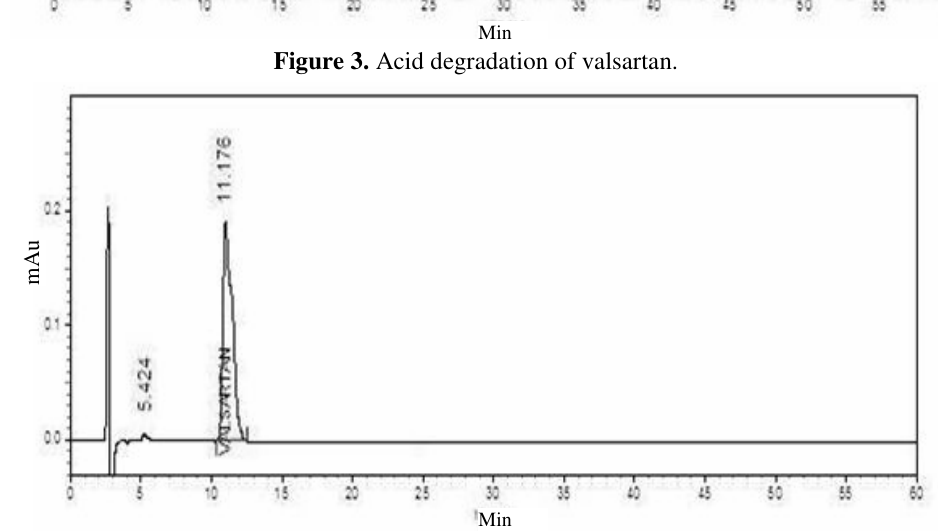
Figure 3. Acid degradation of valsartan.